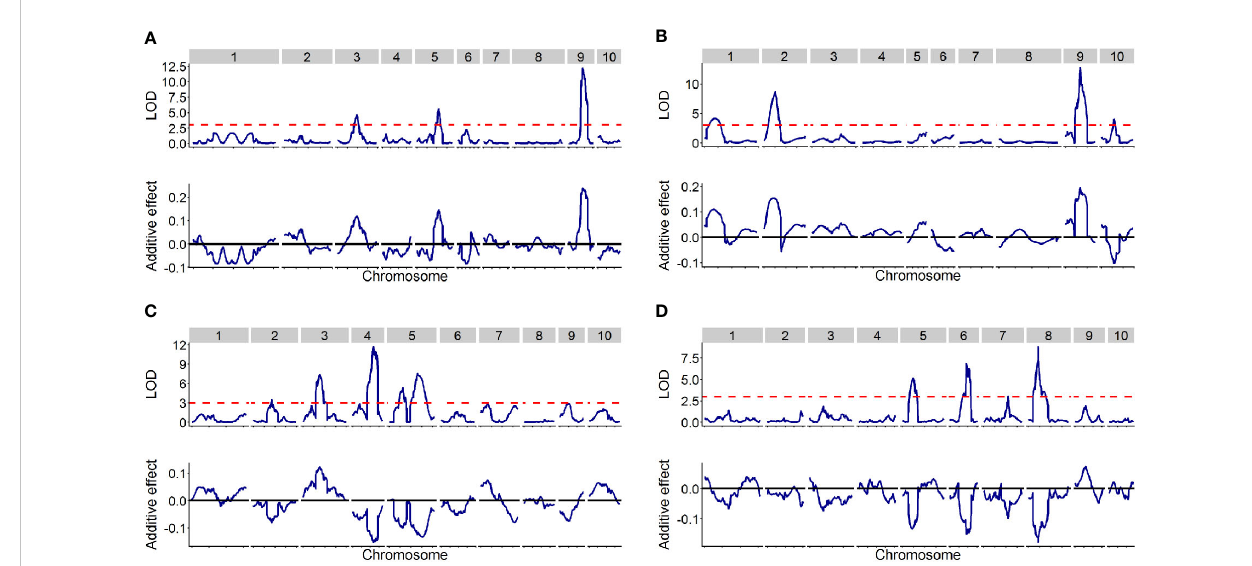
FIGURE 2 The distribution of QTLs across the entire genome in the four DH populations. The upper of each picture displayed LOD score ( y -axis) against the physical position ( x -axis) of markers, while the bottom of the picture displayed additive effect ( y -axis) against the physical position ( x -axis) of markers. (A – D) designated TOC1, TOC2, TOC3 and TOC4, respectively.